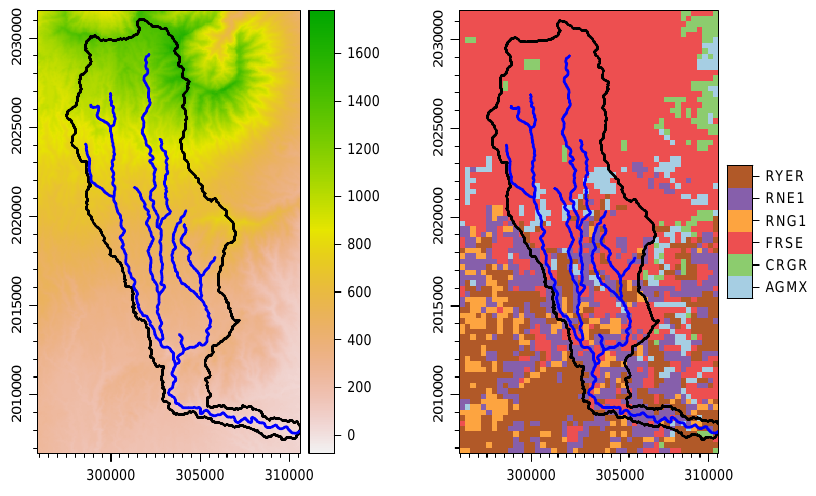
Figure 6. Huazuntlan River Watershed: left : digital elevation model; right : land use distribution. Units in